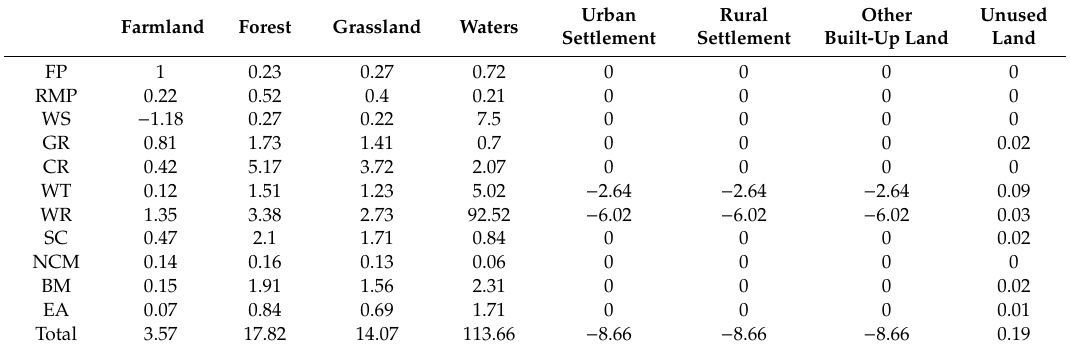
Table 1. Equivalent weight factor of ecosystem service per hectare of terrestrial ecosystems in China. Farmland Forest Grassland Waters